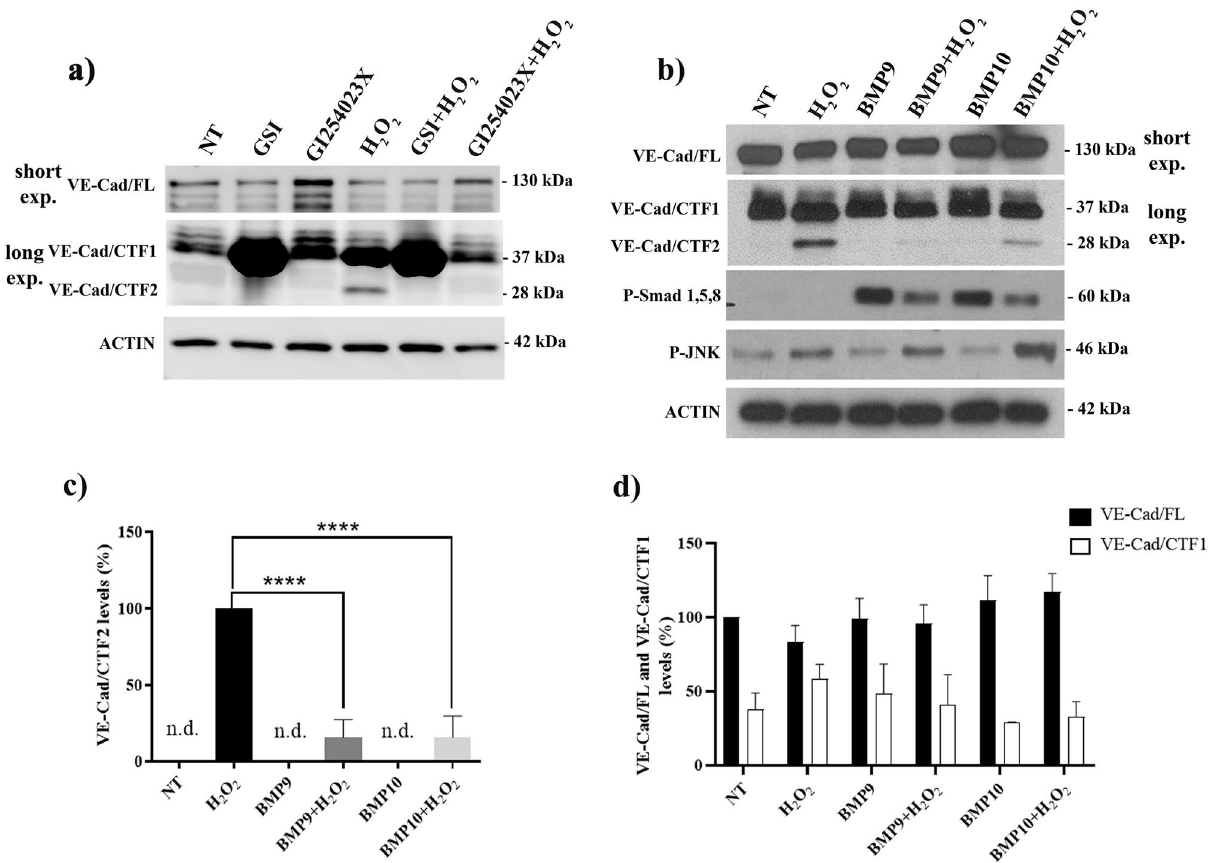
Figure 3. Role of γ-secretase, the metalloproteases, and BMP9/10 in VE-cadherin processing under oxidative stress. ( a ) WB analysis of VE-cadherin in HUVECs exposed to GSI (L-685,458; 1 µM) or GI254023X (10 μM) for 24h before stimulation with H 2 O 2 (500 μM) for 6h. Actin was used as loading control. Note that a digital imager was used for this analysis and some CTF1 bands were overexposed to allow detection of CTF2, see also the corresponding uncropped scans in supplementary material. ( b ) WB analysis of VE-cadherin in HUVECs exposed to BMP9 and BMP10 (10 ng/ml) for 24h before stimulation with H 2 O 2 (500 μM) for 6h. Phospho- Smad1/5/8 was used as a BMP9/10 signaling activation marker. Results are representative of 3 independent experiments. ( c ) Densitometric analyses of VE-Cad/CTF2 levels in different experiments as in ( b ). ( d ) Densitometric analysis of VE-Cad/FL and VE-Cad/CTF1 levels in different experiments as in ( b ). Data in ( c ) and ( d ) are mean ± s.e.m. of 3 independent experiments, **** P